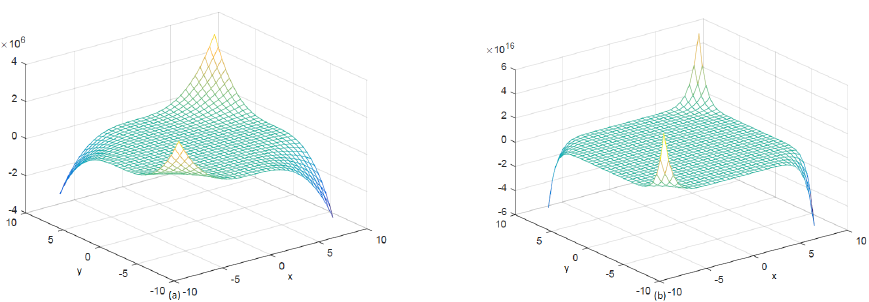
Figure 4: Plotting of (a) M-polynomial and (b) NM-polynomial of aspidostomide